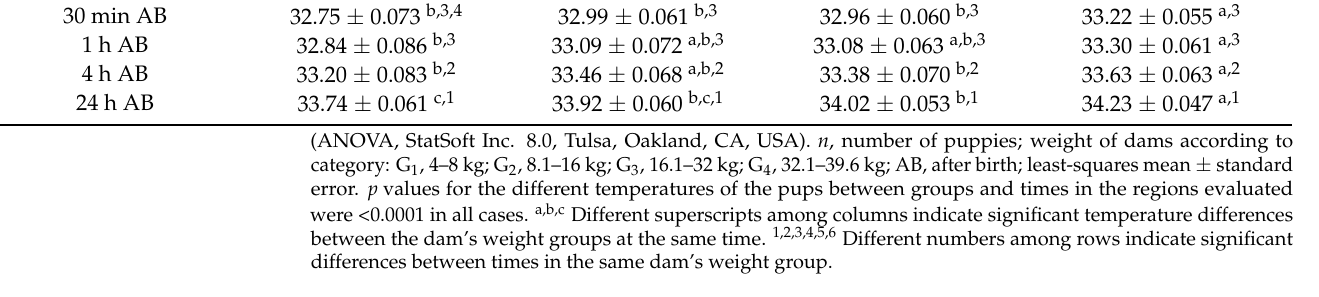
Table 6. Mean temperature ( ◦ C) of femoral pelvic limb (FPL) window at different times in newborn puppies from bitches classified into 4 groups according to its